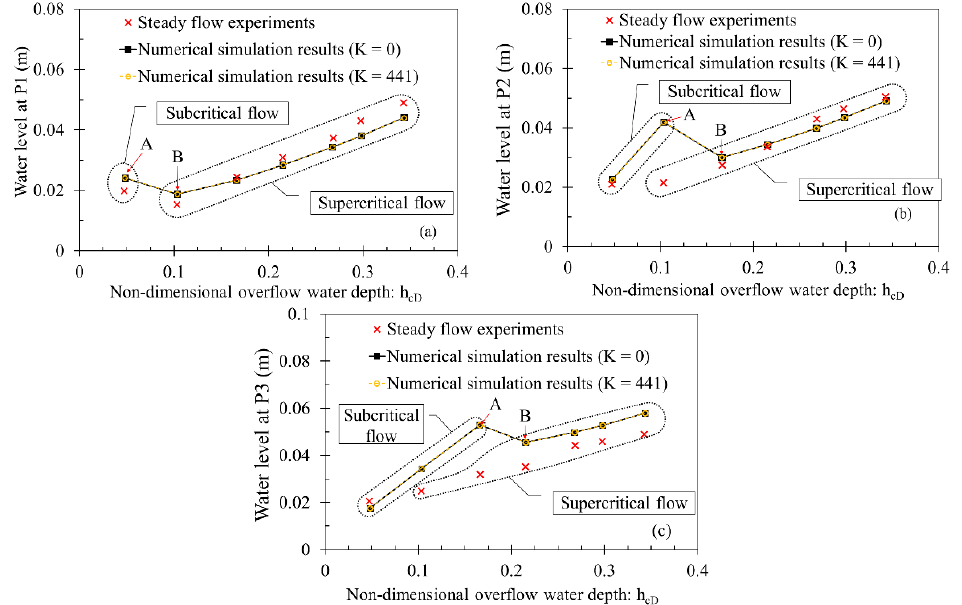
Figure 3. Comparison the simulated water level with experimental data. ( a ) P1, ( b ) P2, ( c )